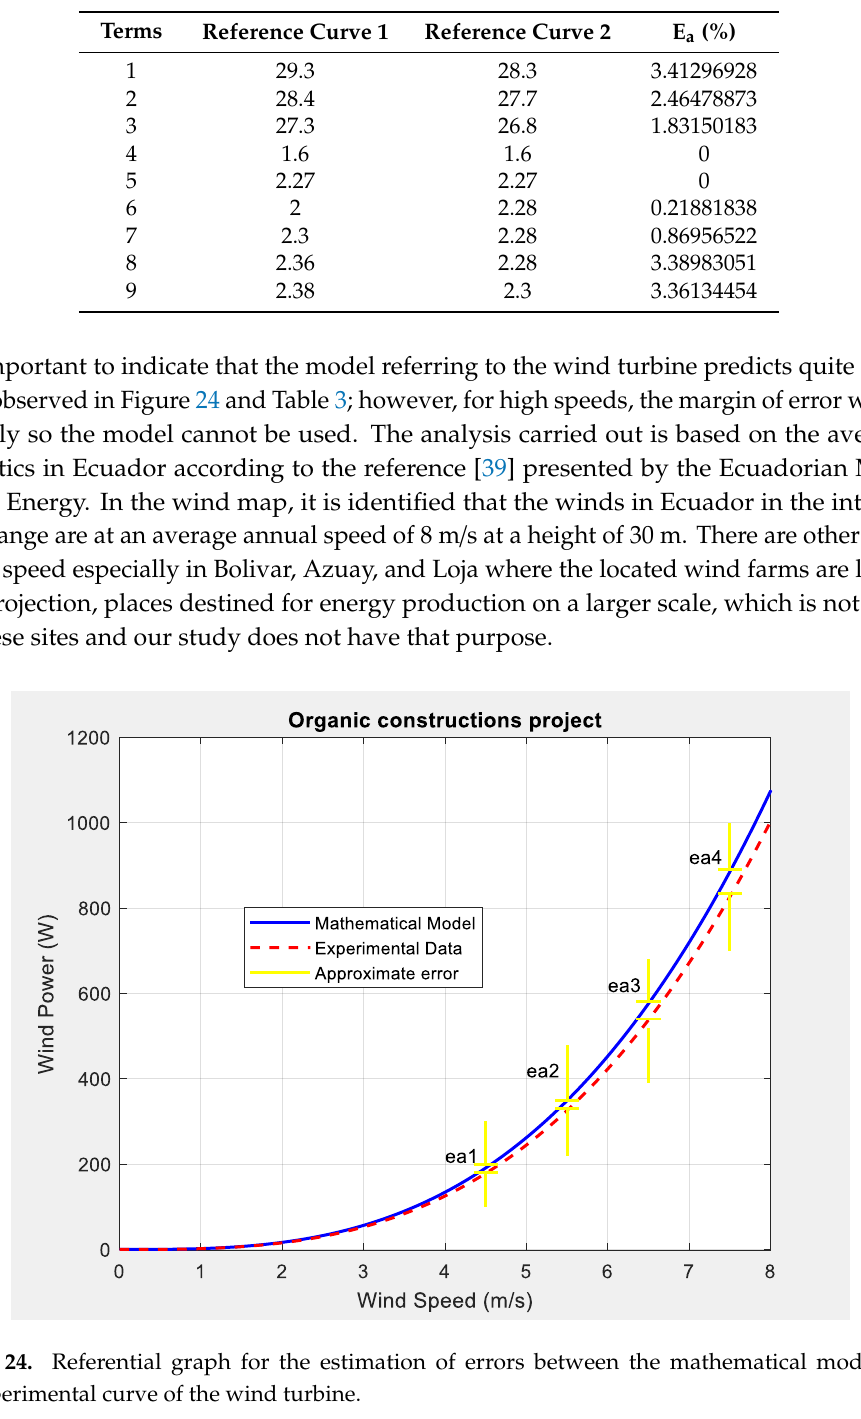
Table 2. Summary table of quantification of maximum percentage errors regarding the PV system.